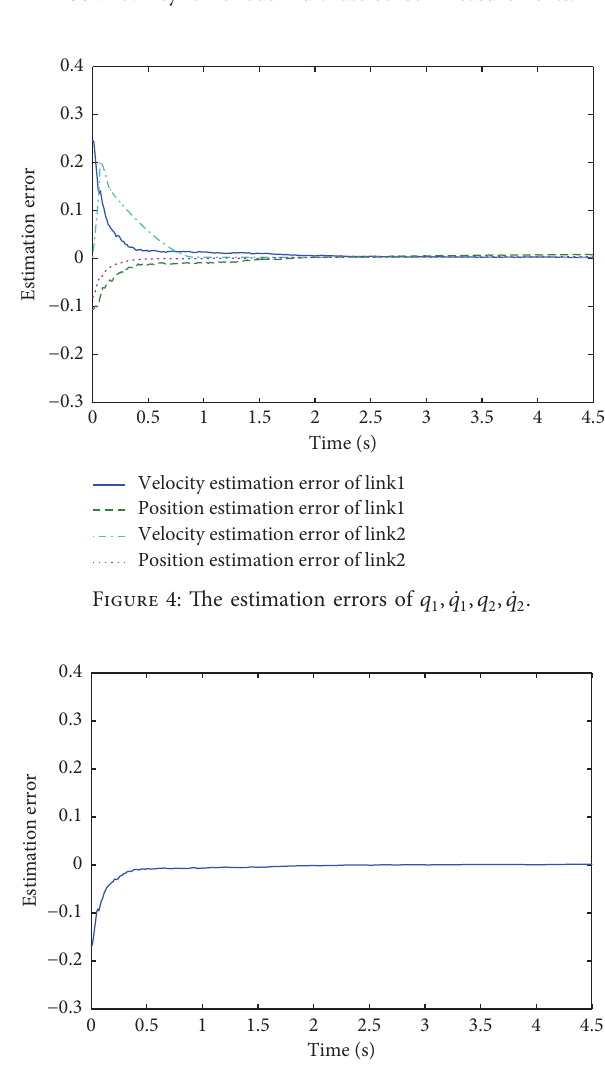
Figure 5: The estimation error of θ .